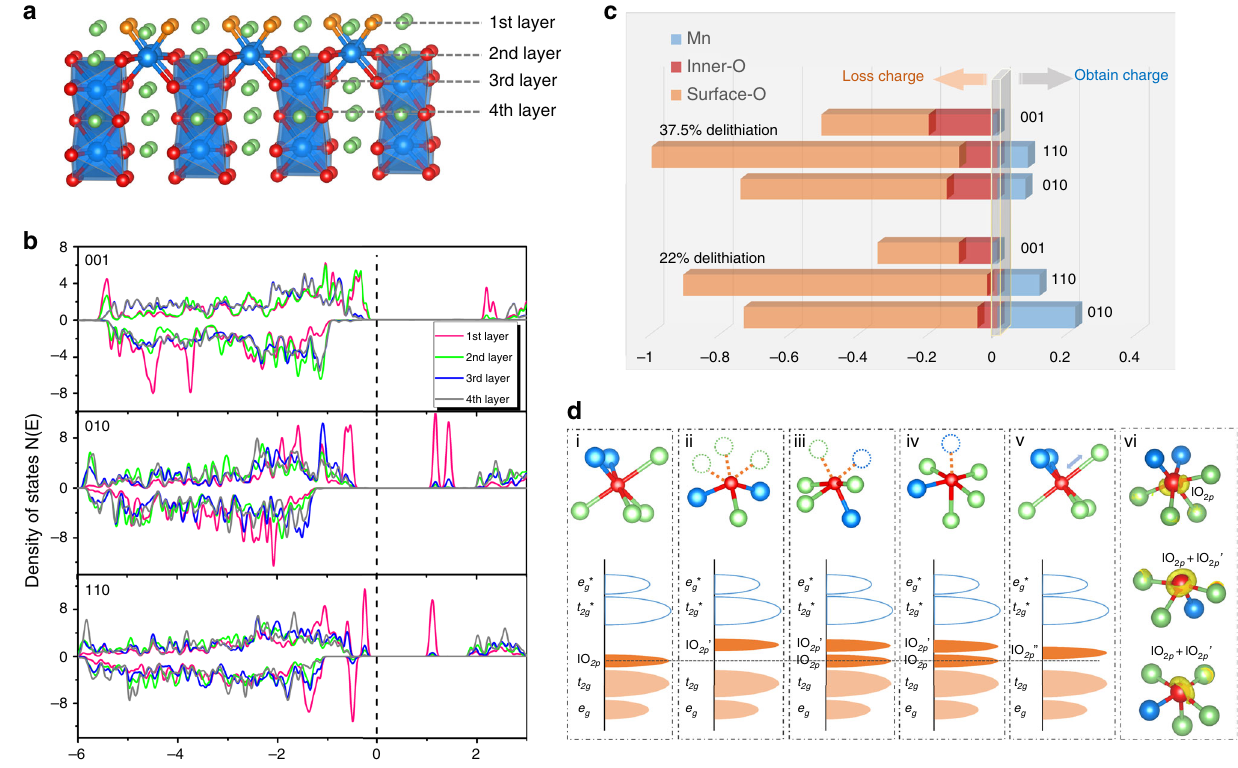
Fig. 1 Redox mechanism on the surface of Li 2 MnO 3 . a Crystal structure of Li 2 MnO 3 (010) surface. The oxygen ions are divided into four layers from the outmost surface to the inner; each layer has the same number of O ions. The blue, green, and red/golden balls represent Mn, Li, and O ions, respectively. b Calculated LDOS of oxygen ions from the fi rst layer to the fourth layer in the (001), (010), and (110) surfaces, respectively. The Fermi level is indicated by the dashed line. c Bader analysis of the surface O, inner O, and Mn ions of the three slabs in different delithiation states. Negative values of the change of Bader charge indicate electron loss of the ions. d Schematic diagram of various local atomic con fi gurations, as well as the electronic structures and the calculated ELF. i, O int , ii, O sur on the (001) surface, iii, O sur on the (010) surface and partial O sur on the (110) surface, iv, partial O sur on the (110) surface, v, oxygen ions in the second layer of the (001) surface, and vi, ELF values computed (isovalues of 0.7) for O int and O sur in iii and iv. The hollow blue area, fi lled orange area, and fi lled light-orange area in each electronic state represents the empty antibonding (M – O) * band, O(2 p ) lone-pair band, and bonding (M – O) band,